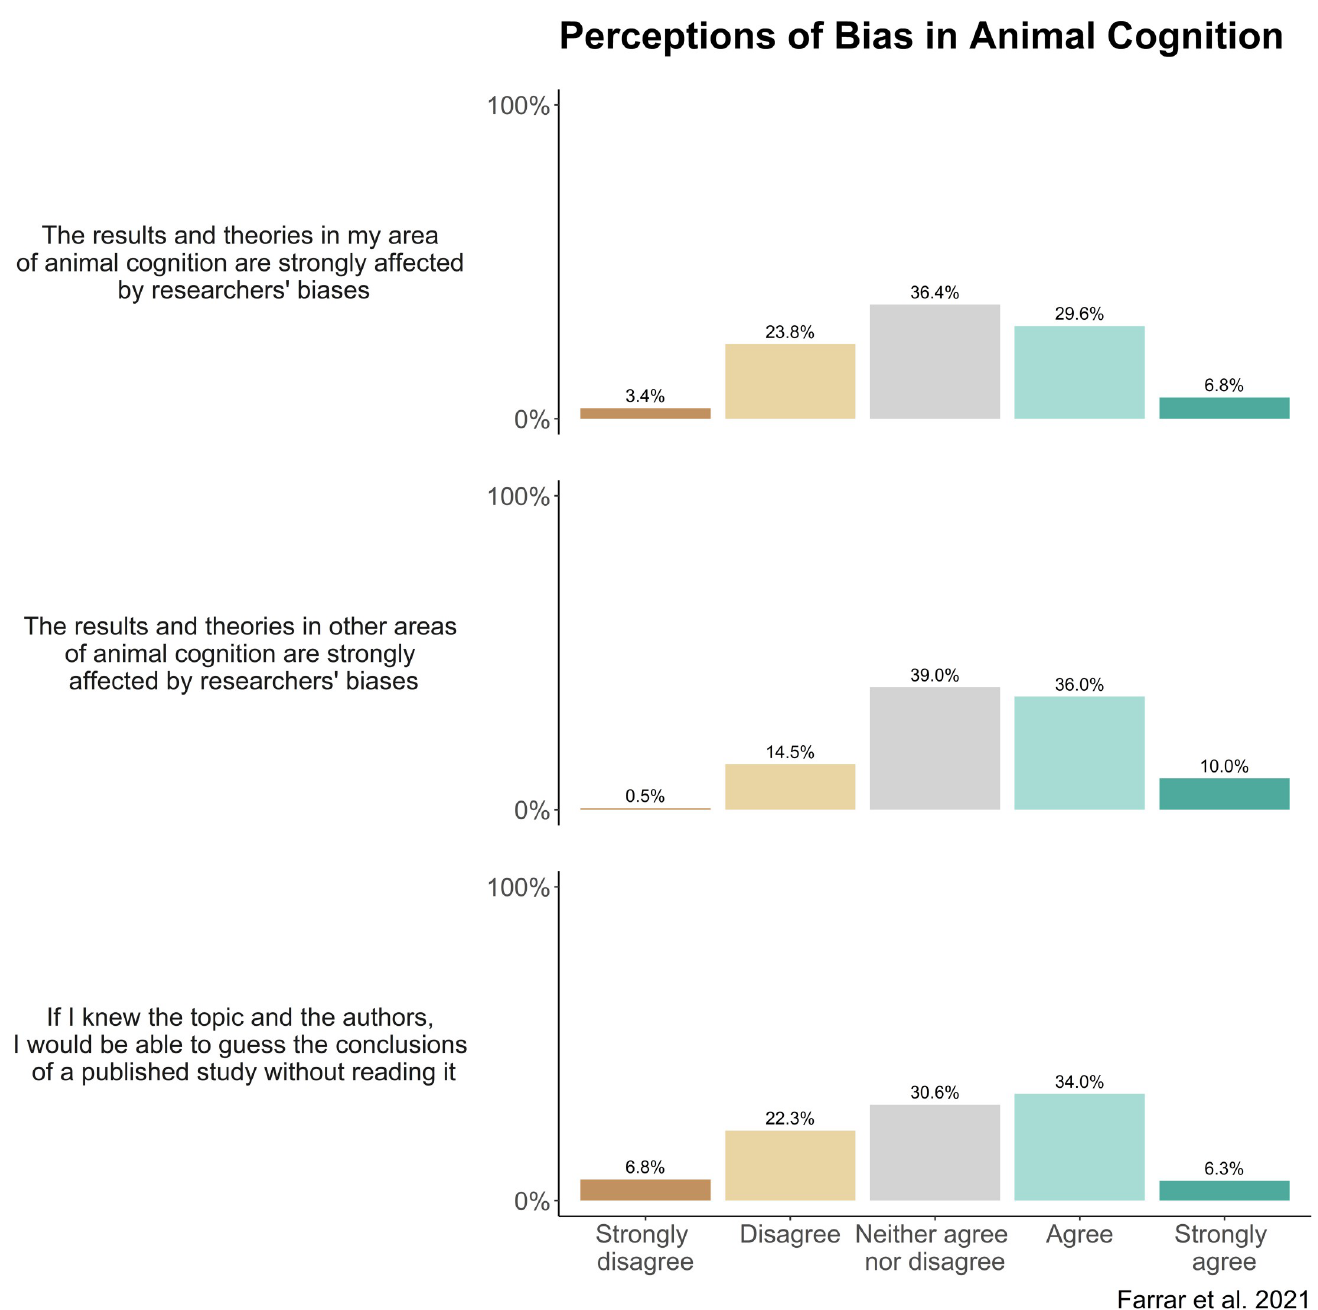
Fig 7. Animal cognition researchers’ self-reported concern about bias in animal cognition research ( N =